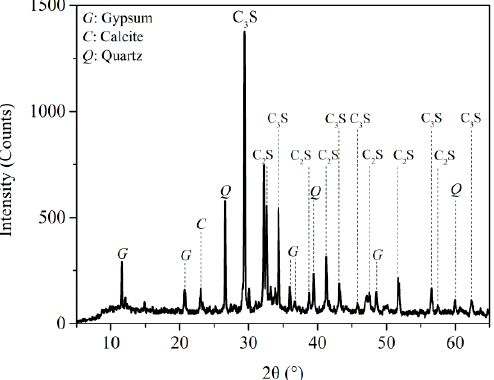
Figure 5. The XRD profile of Portland fly-ash cement and the identification of its basic mineral compositions.